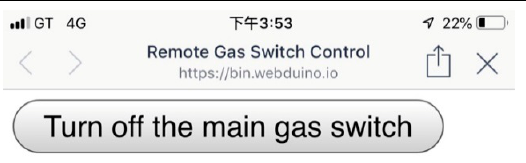
Figure 19. Interface for remotely turning off the gas supply. Appl. Sci. 2019 , 9 , x FOR PEER REVIEW